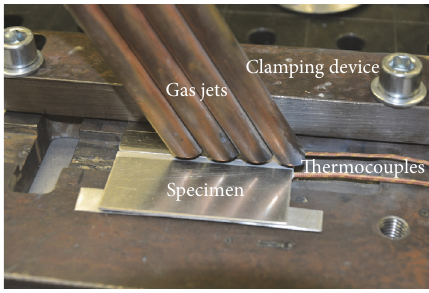
Figure 14: Specimen with thermocouples prepared for welding.